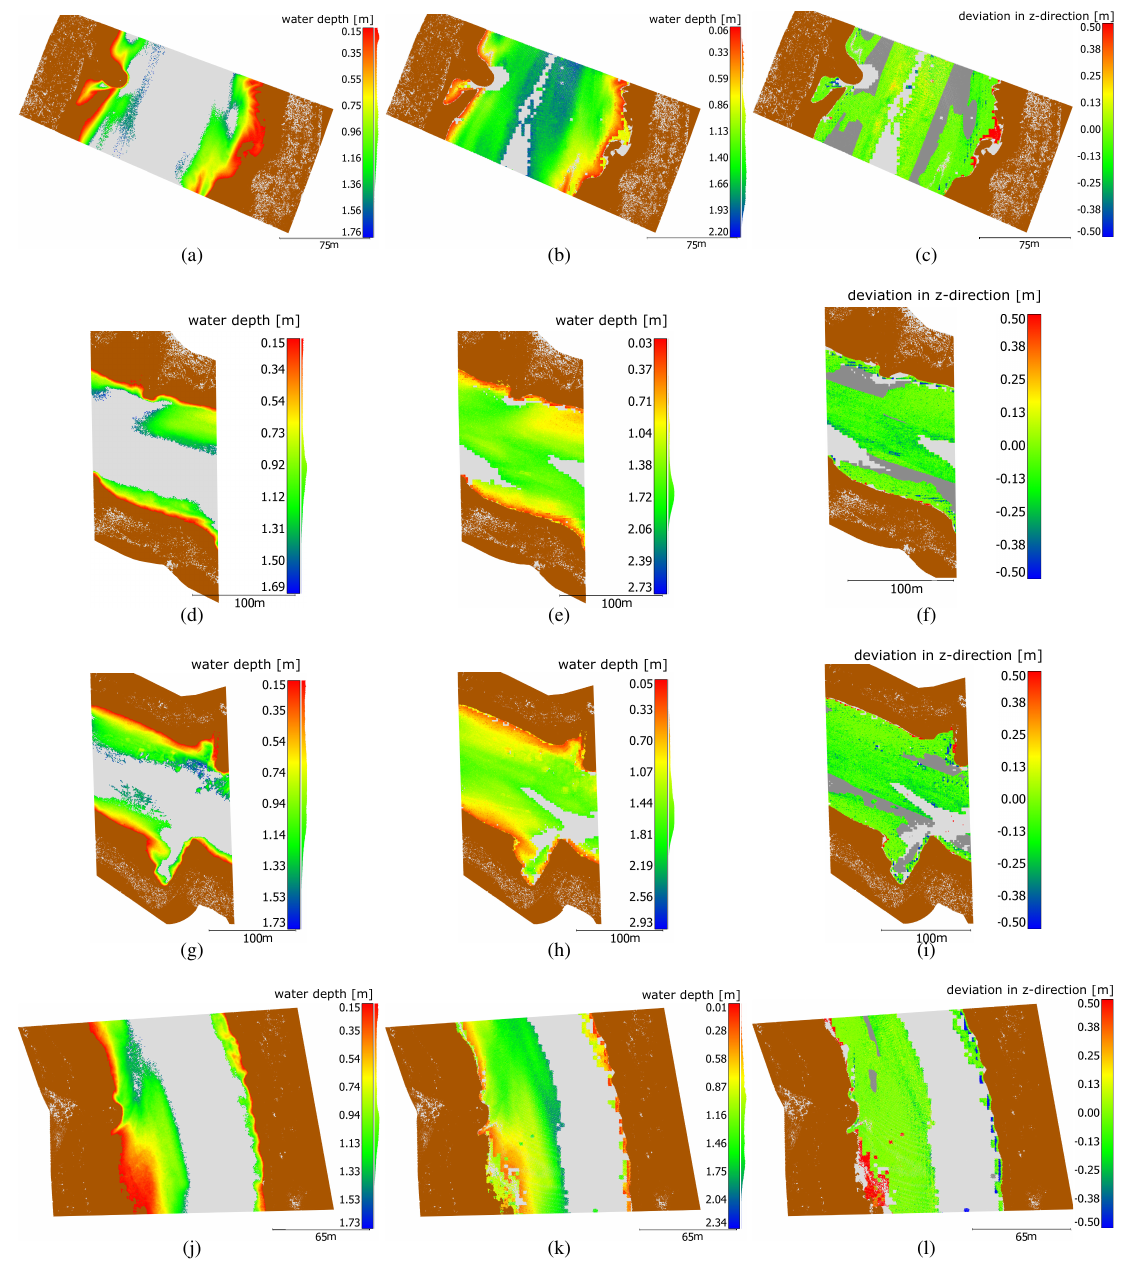
Figure 10. Profile of the riverbed of the river Elbe. Black = Points from online-waveform-processing. Blue = water surface points. Red = points from echo sounder reference. Green = points from full-waveform-stacking method.